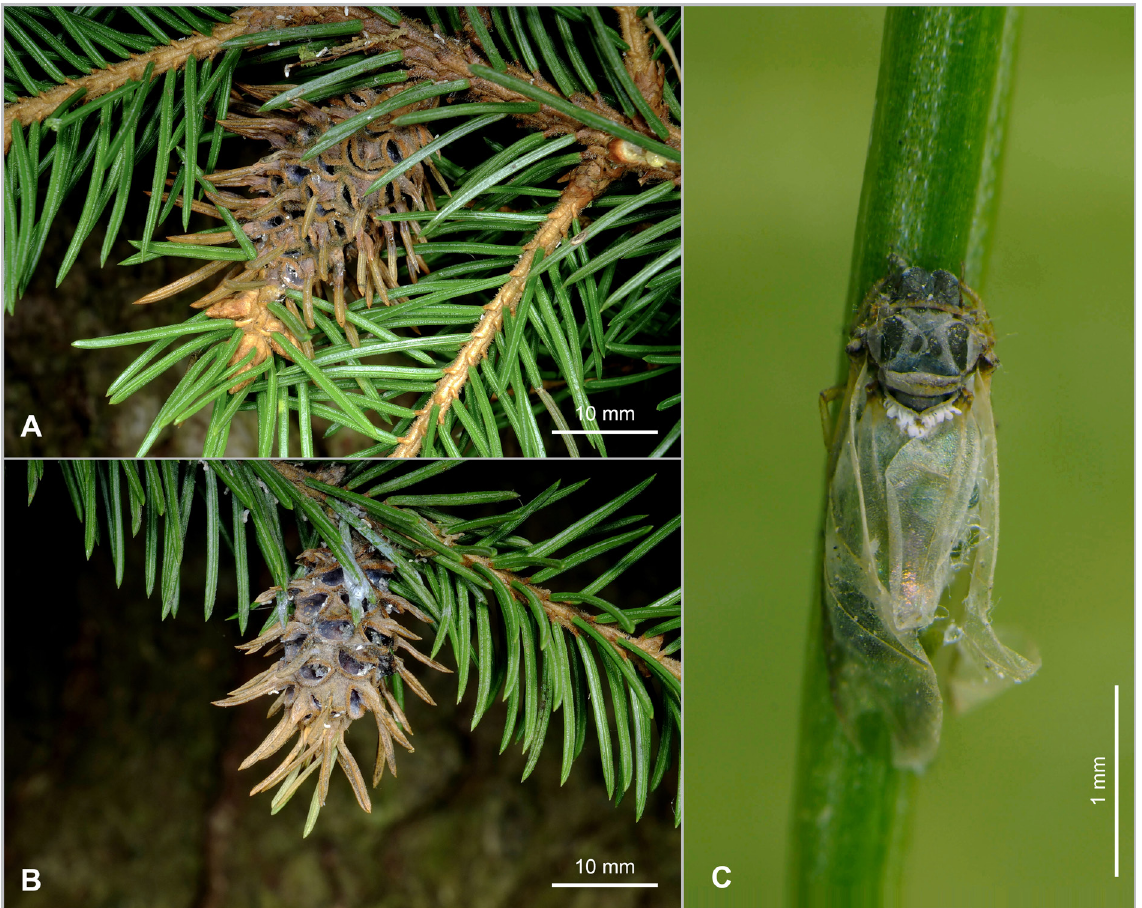
Fig. 22. Adelges (Sacciphantes) viridis (Ratzeburg, 1843). A–B . Abandoned galls on Picea abies . C . Alate gallicola (on Larix decidua